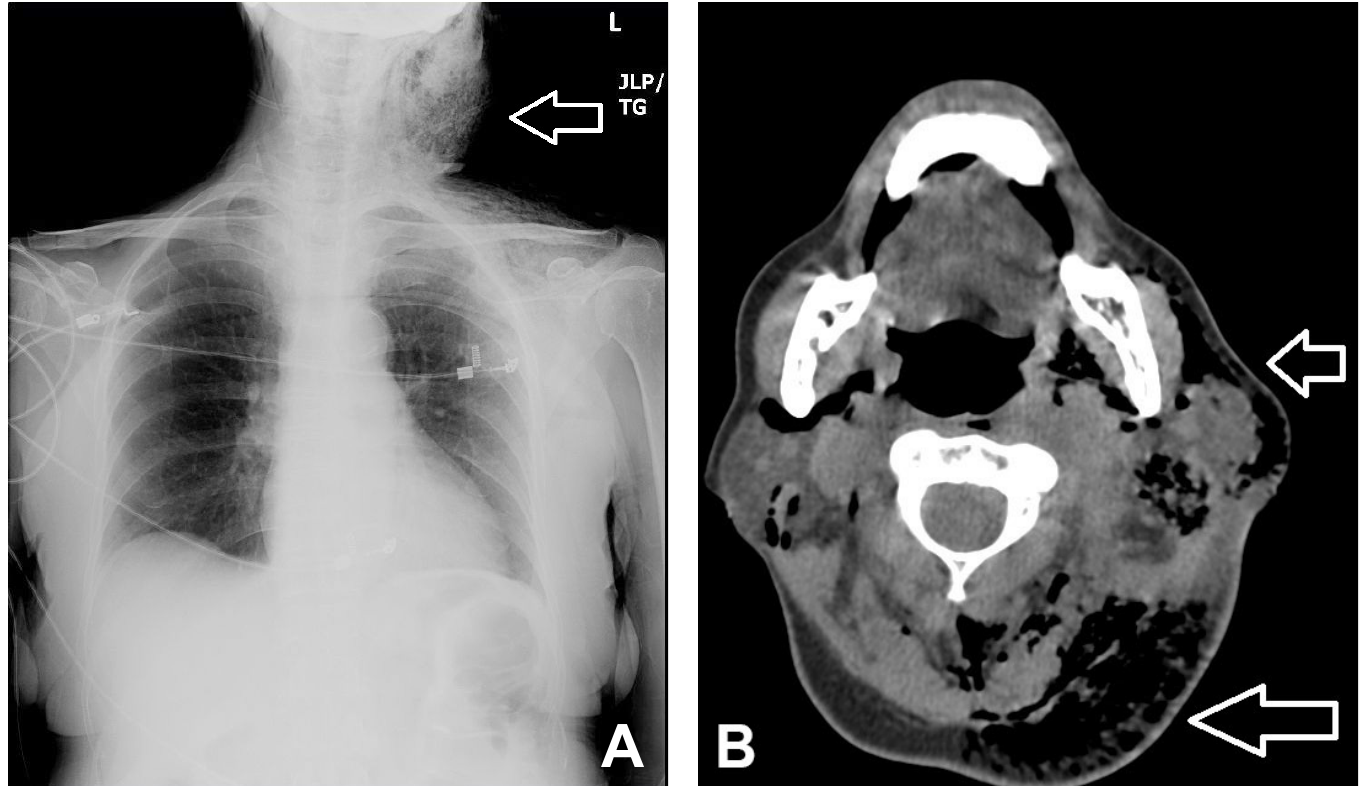
Figure 1. A , Chest radiograph and B , neck computed tomography image at level of C2, both demonstrating left-sided neck mass with extensive subcutaneous emphysema (open